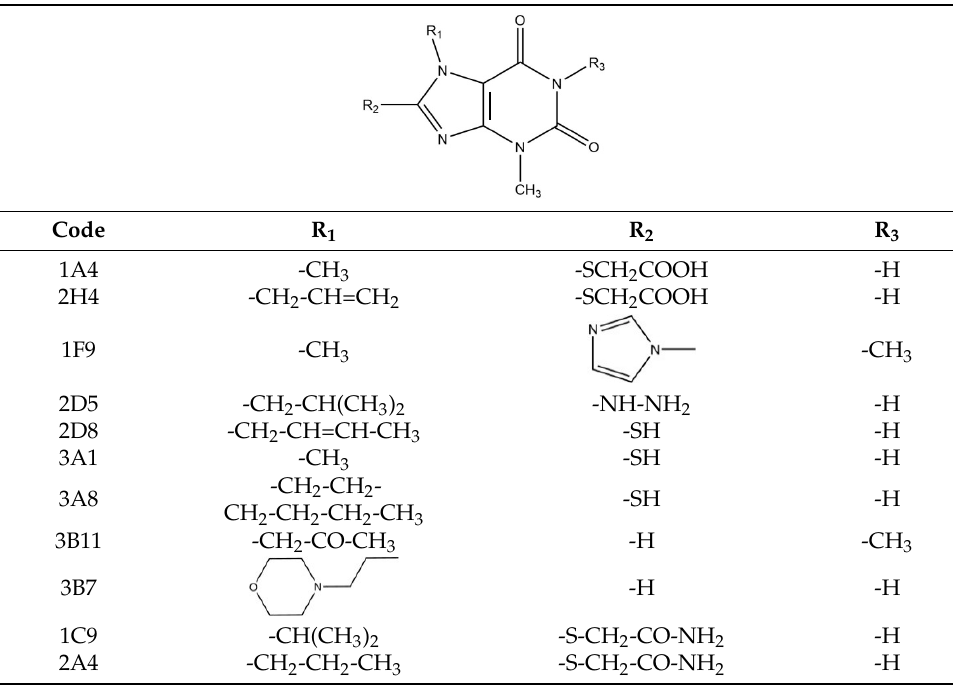
Table 2. Compounds sharing a common structure.